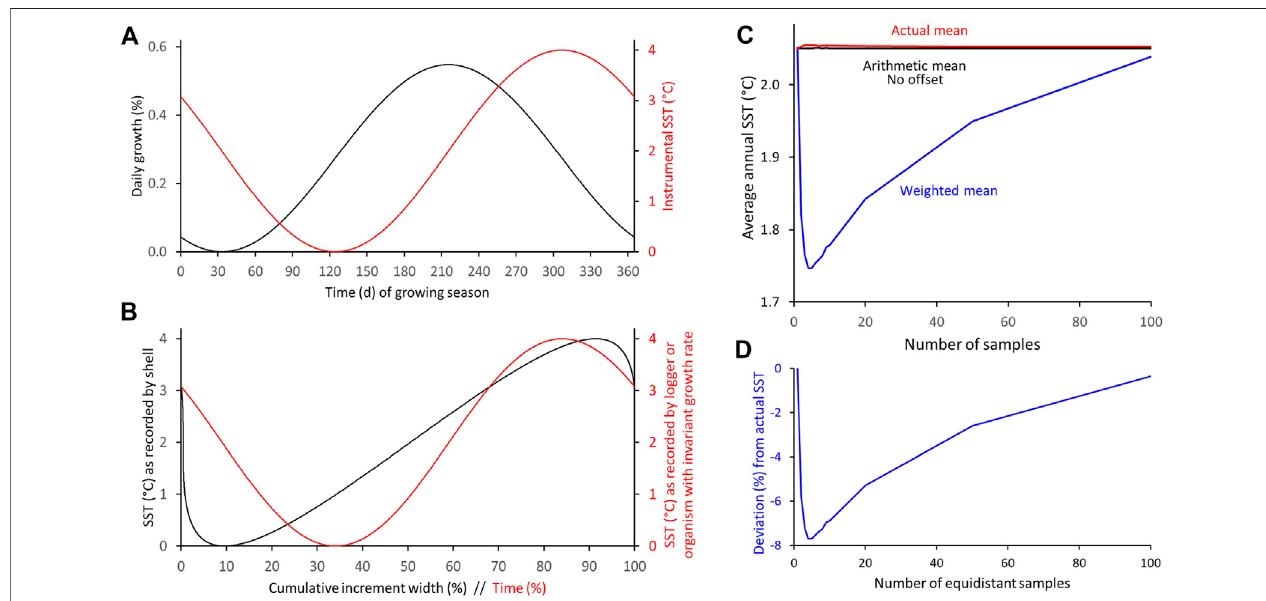
FIGURE7 | Numerical simulationof differences between arithmetic and weighted annual means computed from intra-annual proxy-SST assuming maximum shell growth occurs half-way between SST extremes and both curvesare symmetricallyshaped. (A) Modeled seasonal shellgrowth and SST. (B) SSTas recorded bymodel shell and logger. (C,D) Arithmetic and weighted annual proxy-SST in comparison to actual SST mean. With increasing sample resolution, the weighted mean agrees better with the instrumental SST average (C) : absolute values; (D) : relative values.